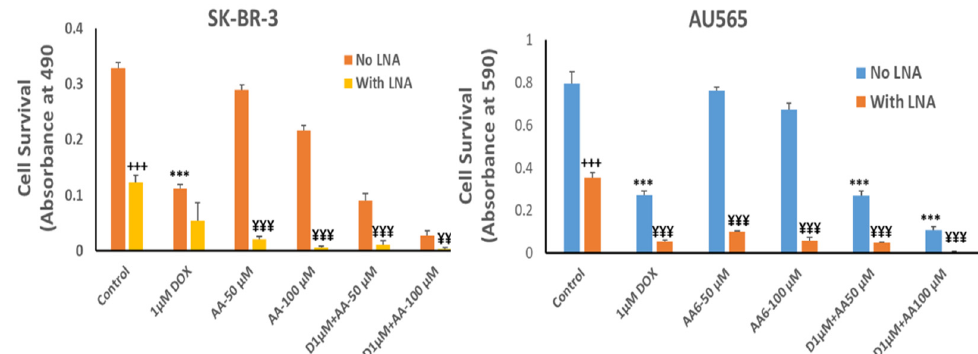
Figure 7. Effects of arachidonic acid and Rlip knockdown on doxorubicin toxicity in breast cancer cells. SK-BR-3 and AU565 cells were Rlip depleted by Rlip-LNA as described above and treated with 1 µM dox (labeled as D in the figures) and 50 or 100 µM AA, alone or in combination, as described in Materials and Methods. After 24 h, cells were analyzed for survival by MTT assay. The data were analyzed by a two-tailed Student t -test. One-way analysis of variance (ANOVA) with Tukey’s post hoc test was applied to compare all groups. The expressed values are means ± SD (n = 3 independent experiments with eight replicates). +++ p<0.001, no LNA vs. LNA control (CAS); * p < 0.05, *** p < 0.001, comparison between no LNA control and AA treatments; ¥¥¥ p < 0.001, comparison between LNA control and AA treatments, as analyzed by a two-tailed Student t